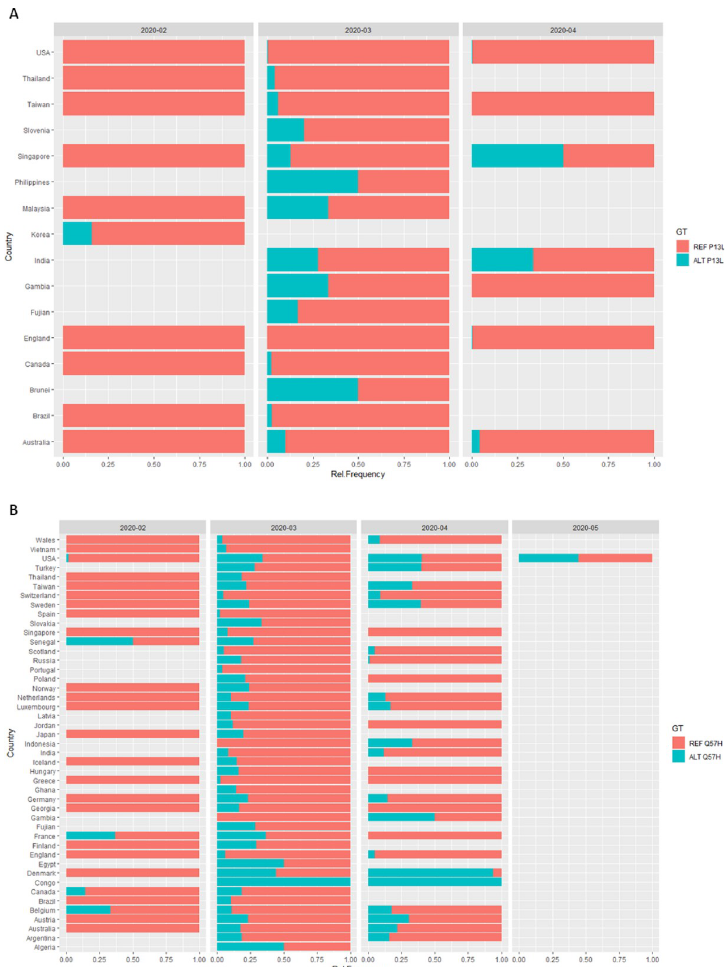
occurrence in Europe (France) to its transmission across the